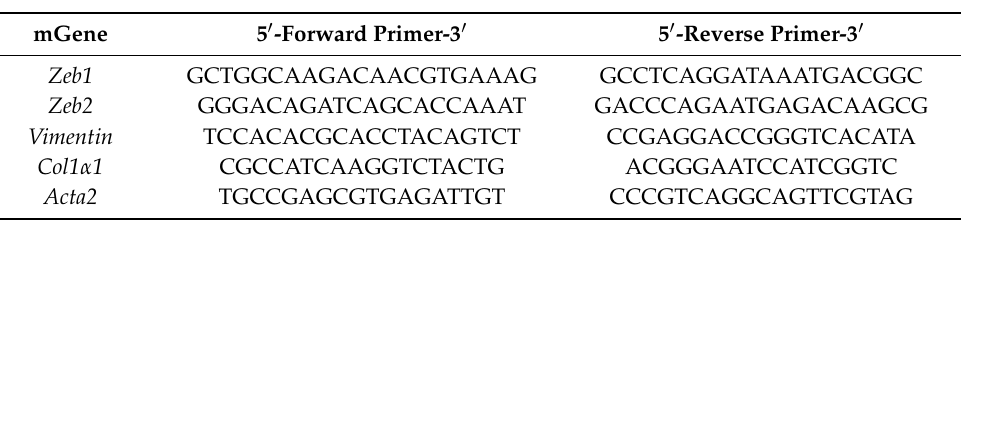
Table 4. PCR primers for